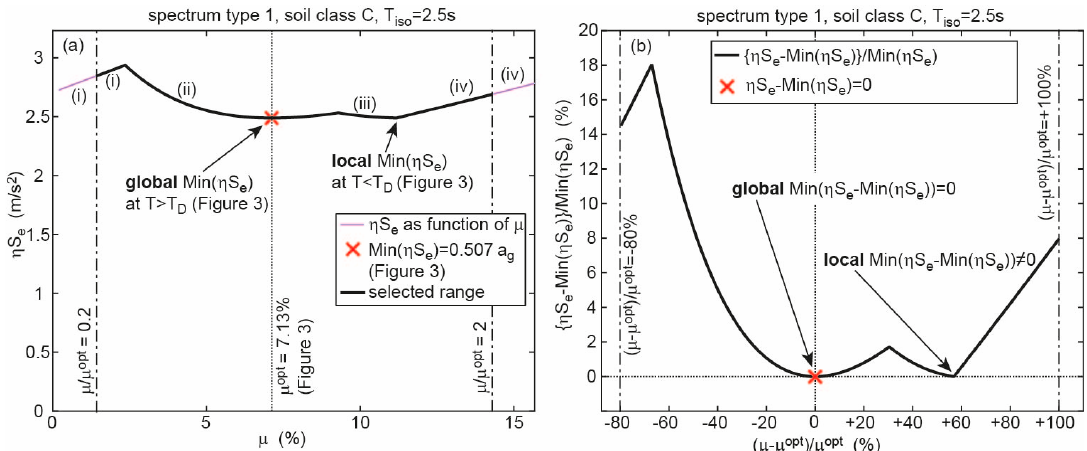
Figure 14. Derivation of sensitivity curves (shown for spectrum type 1 with soil class C and T iso = 2.5 s): ( a ) reduced acceleration response η S e as function of friction coefficient µ and ( b ) according sensitivity curve.